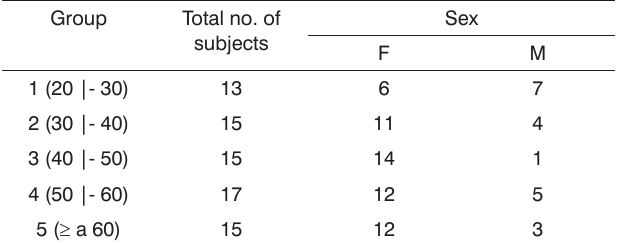
Table 1. Distribution of the series in this study according to sex and age